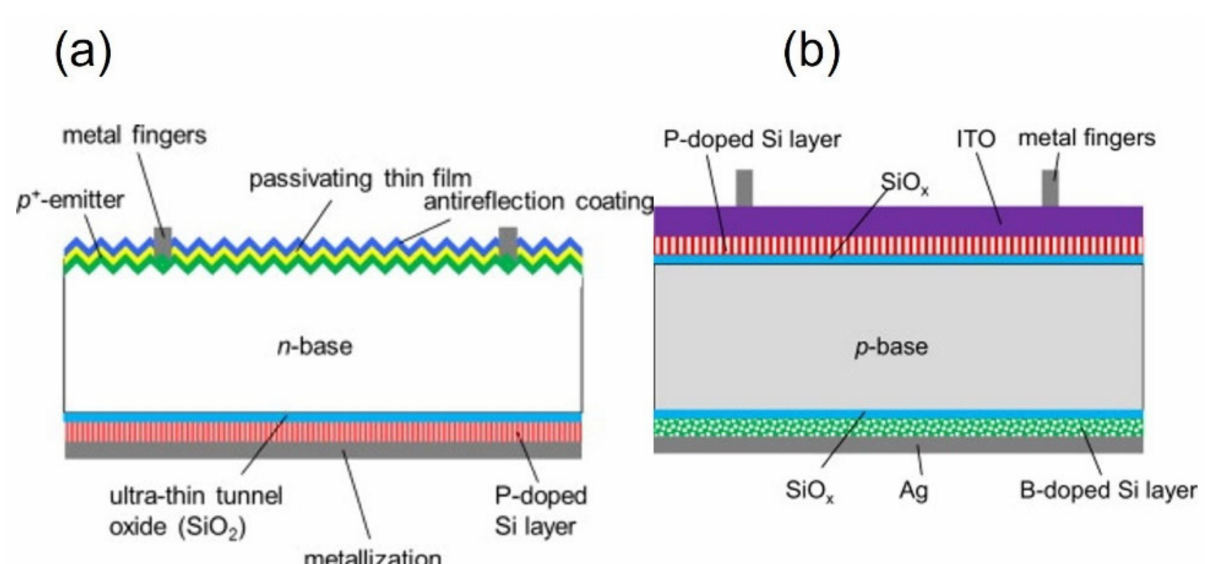
Figure 5. ( a ) Schematic diagram of hybrid n-type c-Si solar cell with full area p + polysilicon/SiO 2 rear contact (Reprinted from Ref. [53] Solar Energy Materials and Solar Cells, Vol. 120, F. Feldmann, M. Bivour, C. Reichel, M. Hermle, S.W. Glunz, Passivated rear contacts for high-efficiency n-type Si